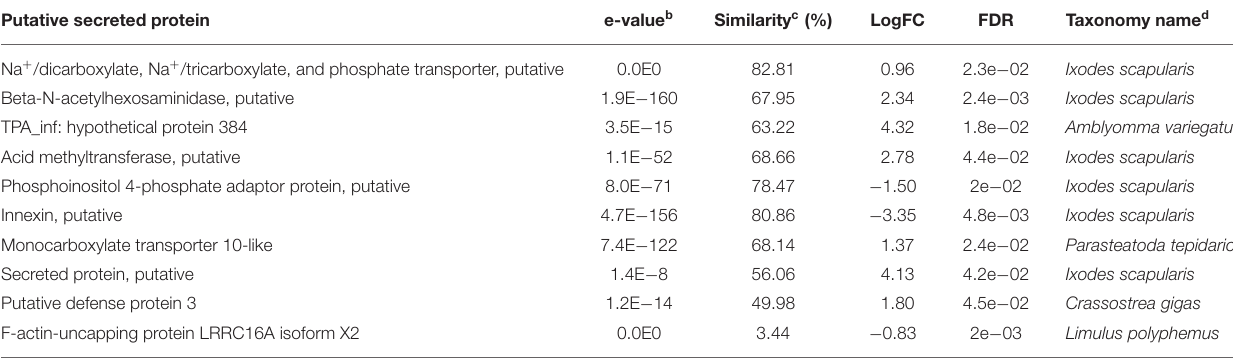
TABLE 1 | Putative secreted proteins a transcribed in R. ( B .) microplus salivary glands. Putative secreted